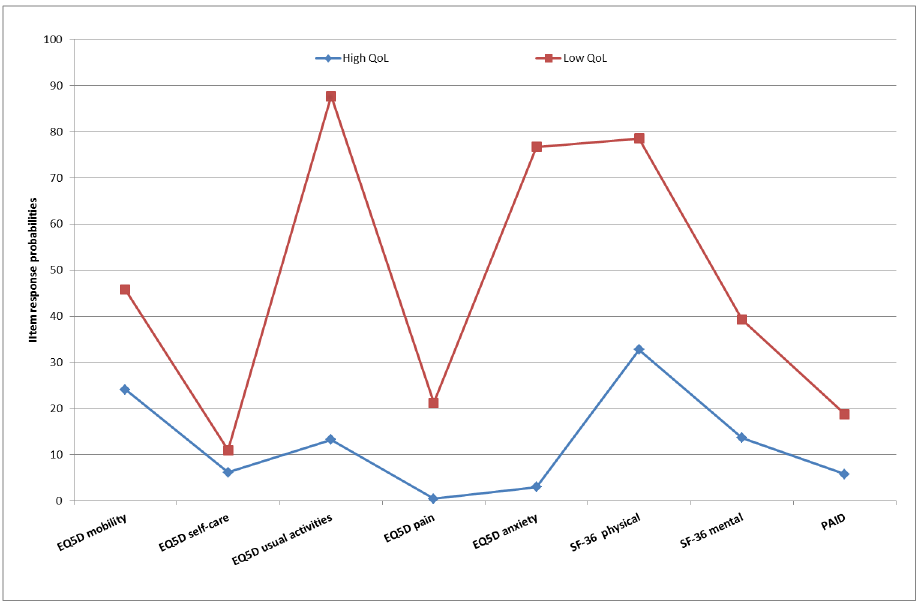
Fig 1. Two-class model for HRQoL in patients with insufficient glycaemic control (HbA1c > 7.0% [53 mmol/mol]). High HRQoL class, N = 220 (71.4%); low HRQoL class, N = 88 (28.6%).